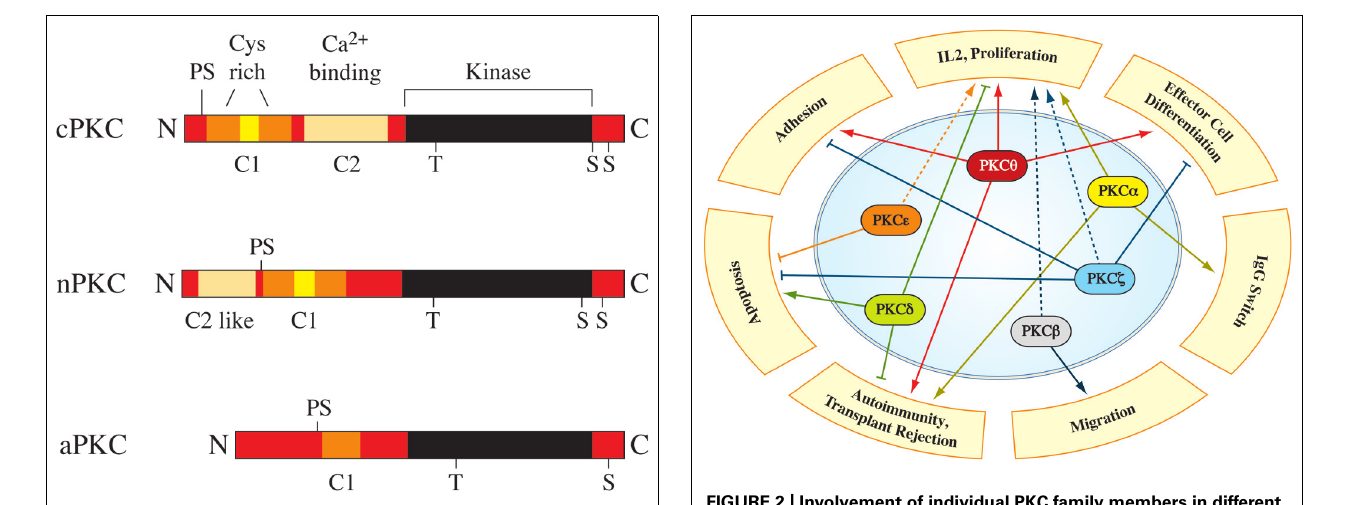
FIGURE 2 | Involvement of individual PKC family members in different aspects of T cell biology. Numerous studies identified PKC isotype-selective functions in signaling pathways, necessary for fullT cell activation, differentiation and robust immune responses in vivo (for details see text).The dashed line depicts PKC functions which were characterized primarily via overexpression/knockdown studies in immortalized cell lines, while a validation in a more physiological system is